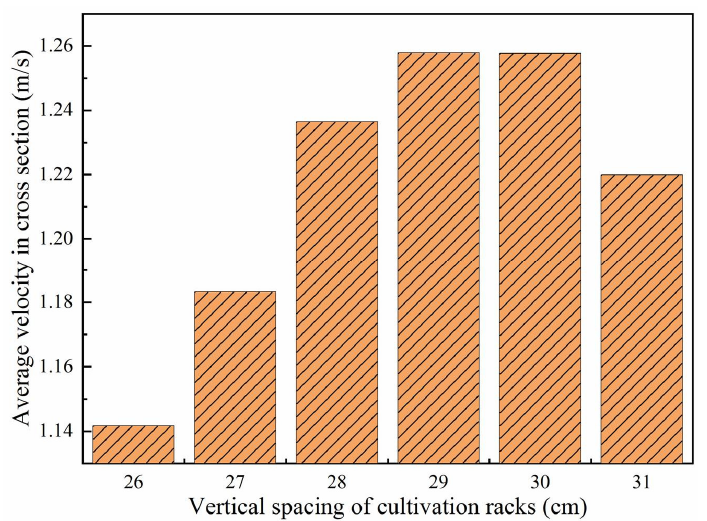
Figure 12. Velocity magnitudes of typical cross sections under different vertical spacings of culti- vation racks.